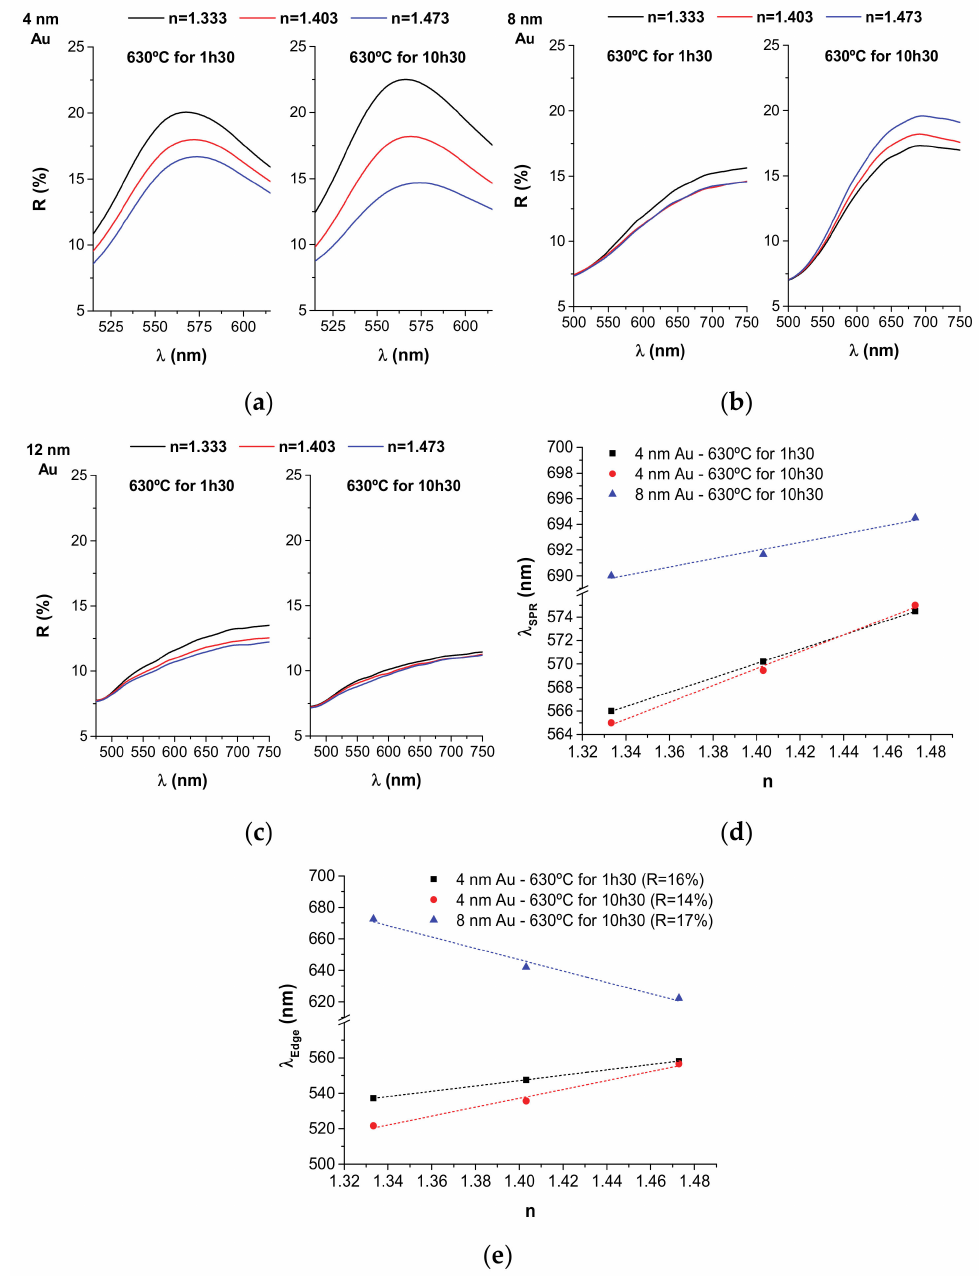
Figure 5. Reflectance curves of the annealed samples containing liquids with varying refractive indices: ( a ) 4 nm Au; ( b ) 8 nm Au; ( c ) 12 nm Au. The baseline of some curves in samples 8 and 12 nm Au were slightly moved up or down in intensity in order to match with the remaining curves in the lower wavelengths; ( d ) Variation of the LSPR peak position ( λ SPR ) with the surrounding refractive index (for the best samples in this study); ( e ) Variation of the LSPR band edge ( λ Edge ), for a fixed reflectance reference value, with the surrounding refractive index (for the best samples in this study). The linear trend lines are just a guide to the